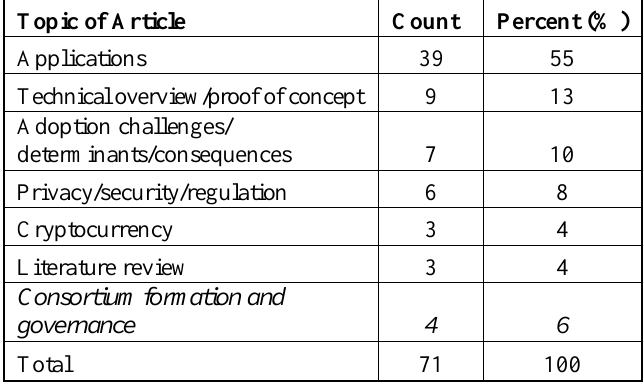
Table 1: Analysis of Literature Results by